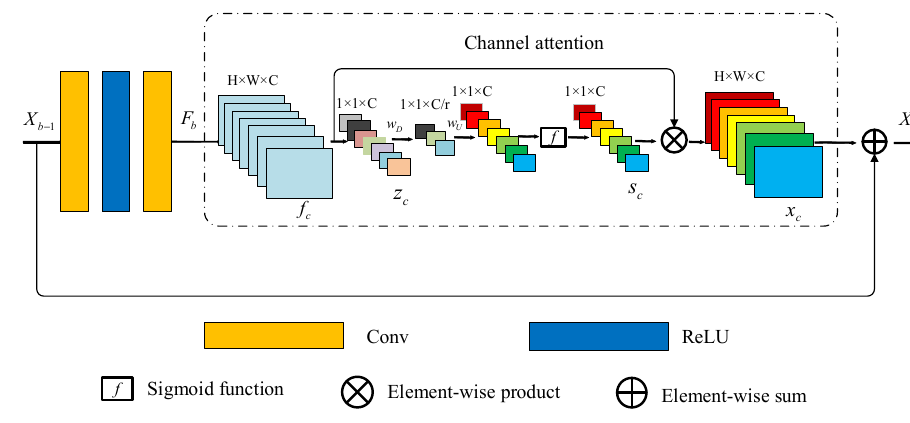
Figure 2. Residual channel attention block (RCAB).